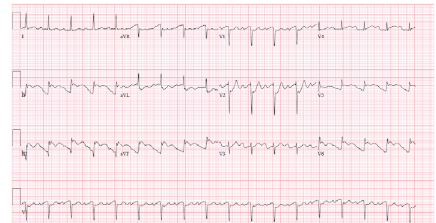
Figure 3: ST elevation in inferior and lateral leads (case 1).